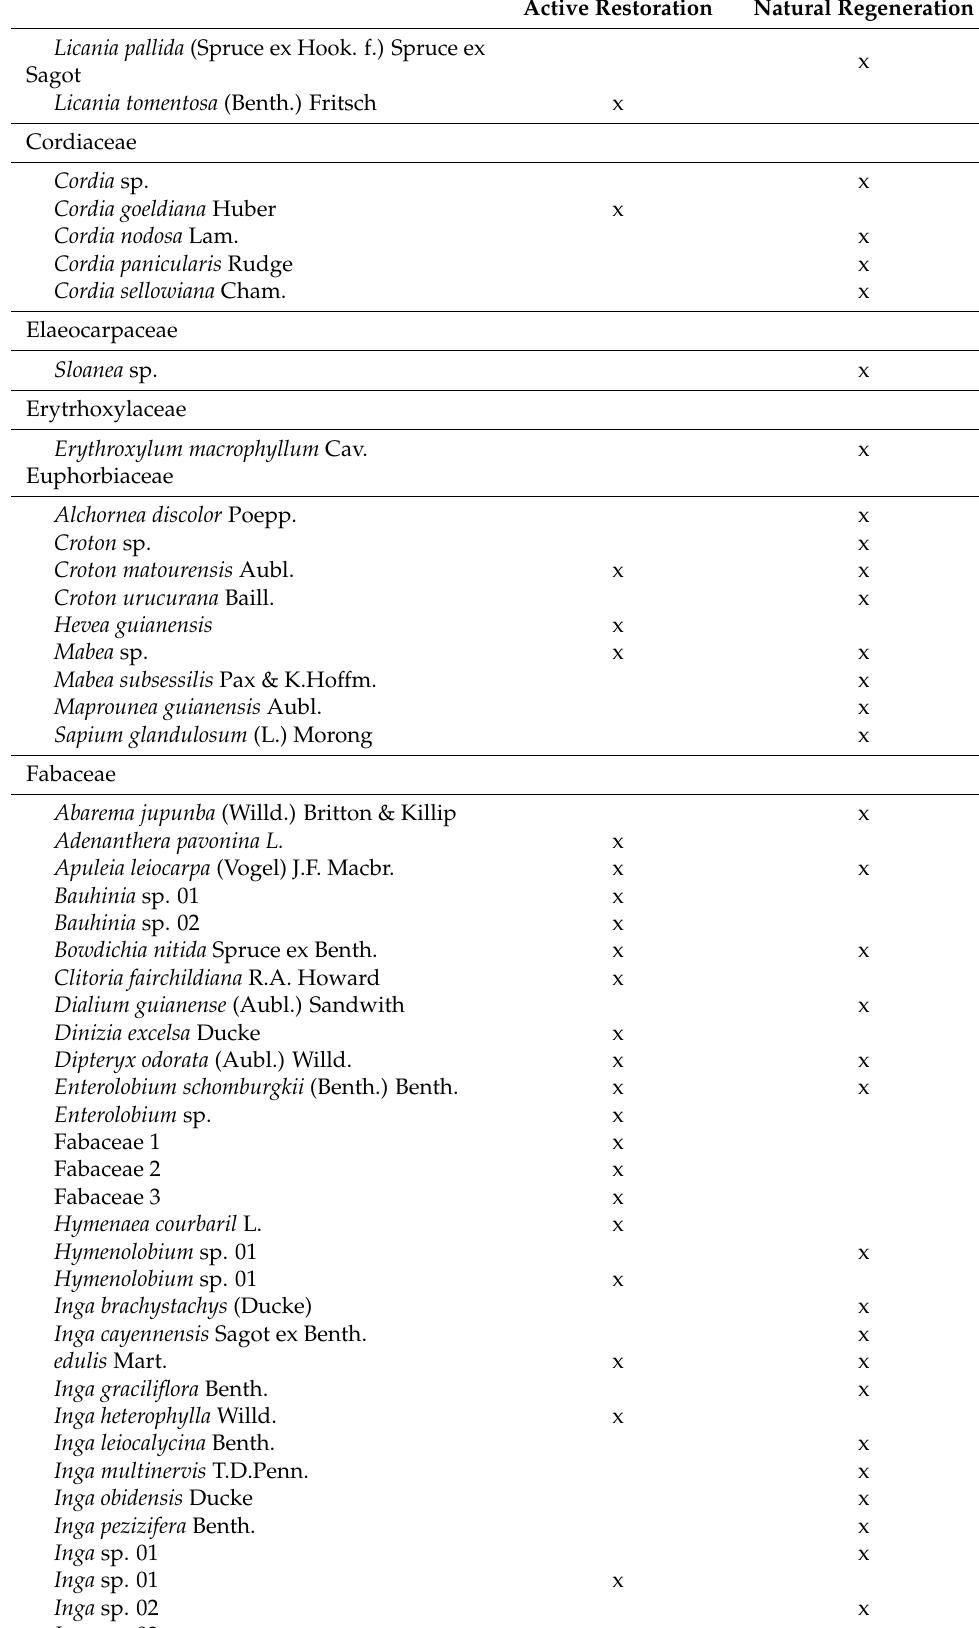
Active Restoration Natural Regeneration x